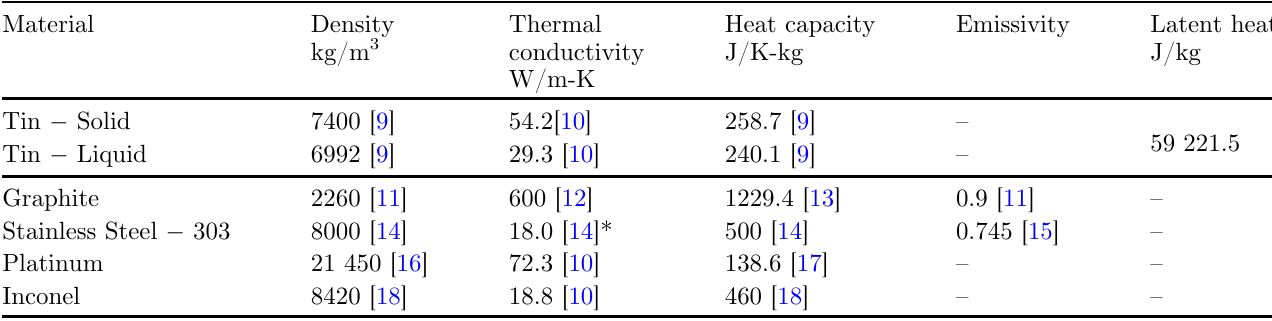
Table 1. Thermophysical properties of the materials used.